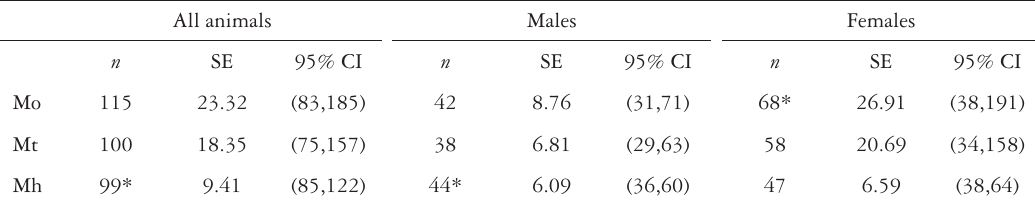
Table 3. Estimation of population size, n , based on genetic sampling using program CAPTURE (White et al., 1982) with 2009 sampling information from Slate Islands Provincial Park woodland caribou population. All animals